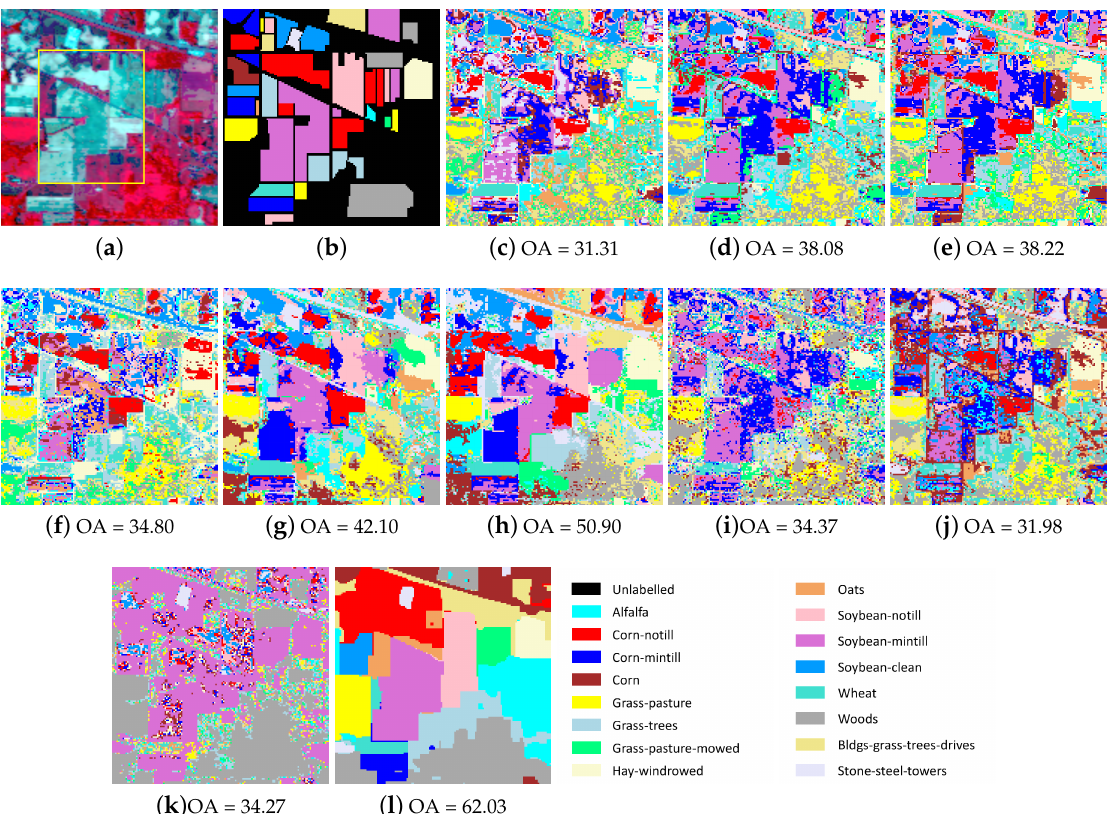
Figure 5. Indian Pines image. ( a ) False color image (yellow box is the cropped image), ( b ) Ground truth, and Clustering maps of ( c ) Fuzzy c-means (FCM), ( d ) k-means, ( e ) Random swap clustering (RSC), ( f ) SSC, ( g ) L2-SSC, ( h ) JSSC , ( i ) SSSC, ( j ) SSC-OMP, ( k ) Sketch-SSC and ( l )